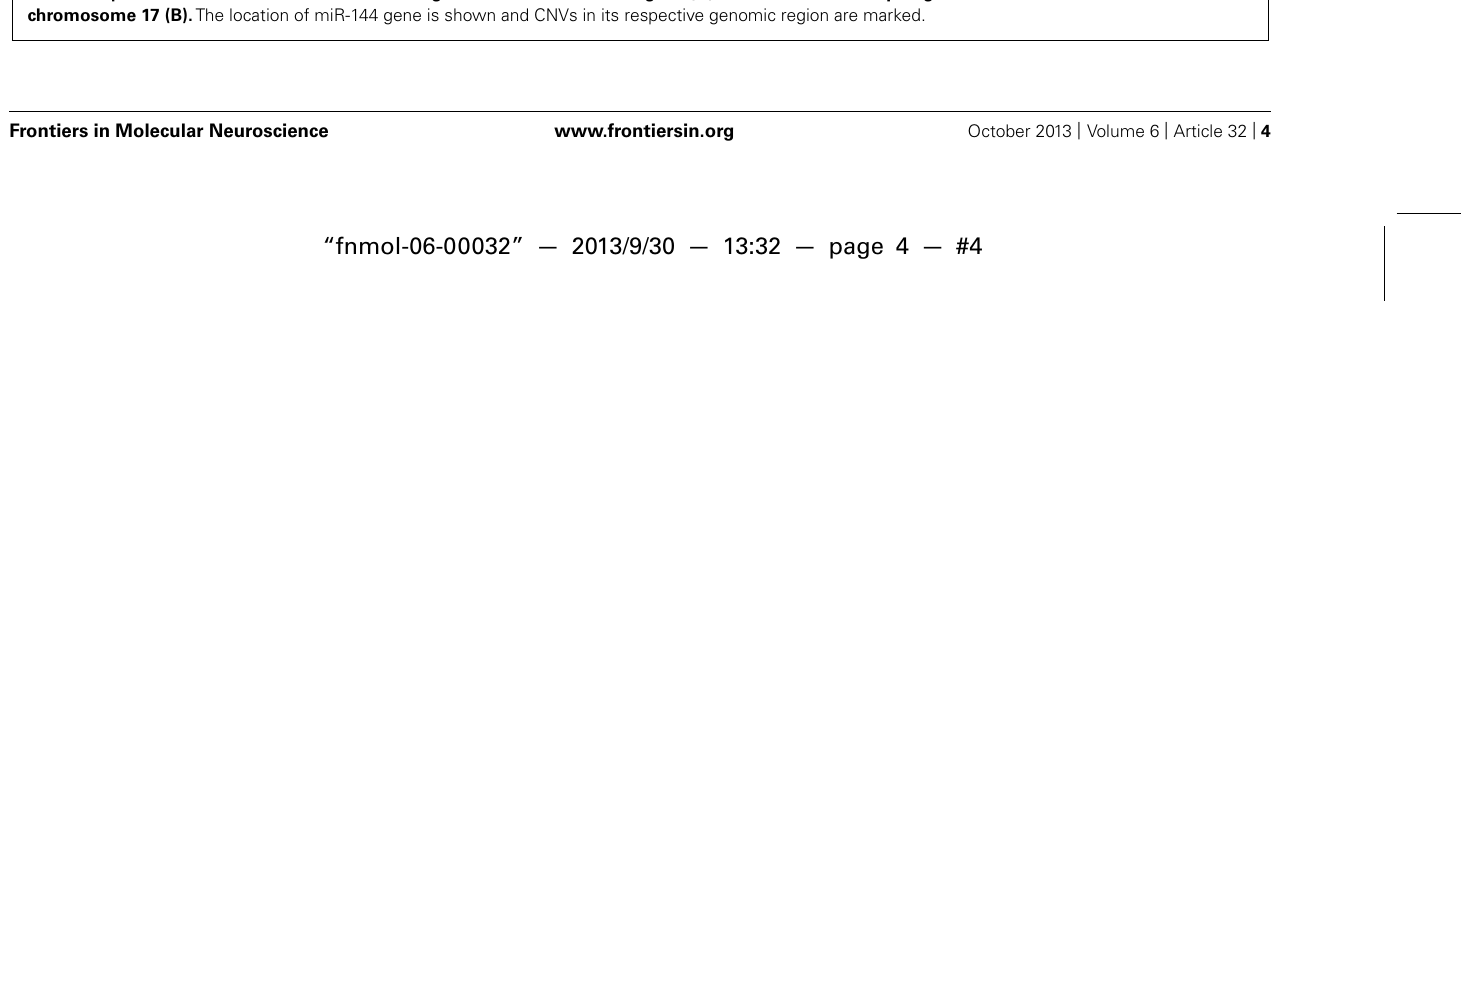
FIGURE 2 | Schematic of chromosome 17 showing the location of miR-144 gene (A); and distribution map of genetic variants identified in chromosome 17 (B). The location of miR-144 gene is shown and CNVs in its respective genomic region are marked.